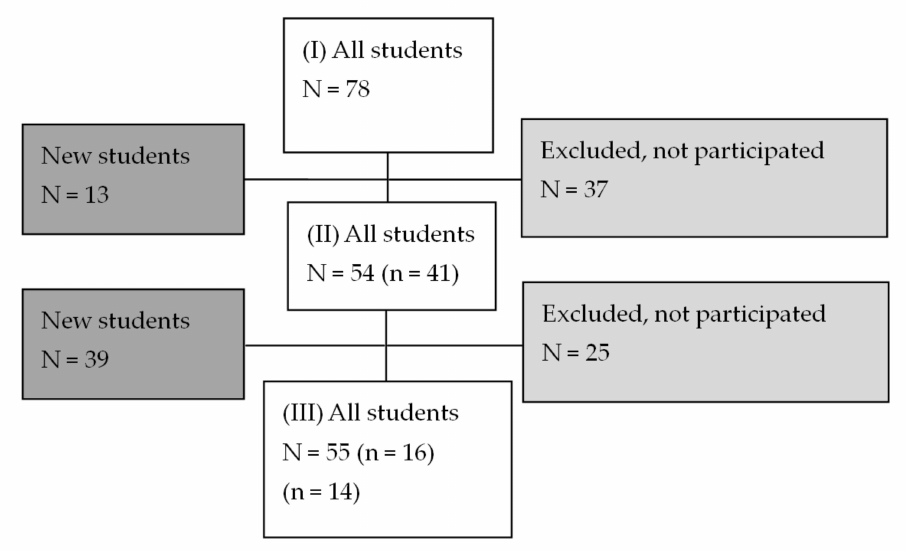
Figure 1. Data flow of vocational school students in the pooled and panel dataset. Note: IHC, individual health coaching. N represents all students, n represents the number of students in both waves in one vocational school in